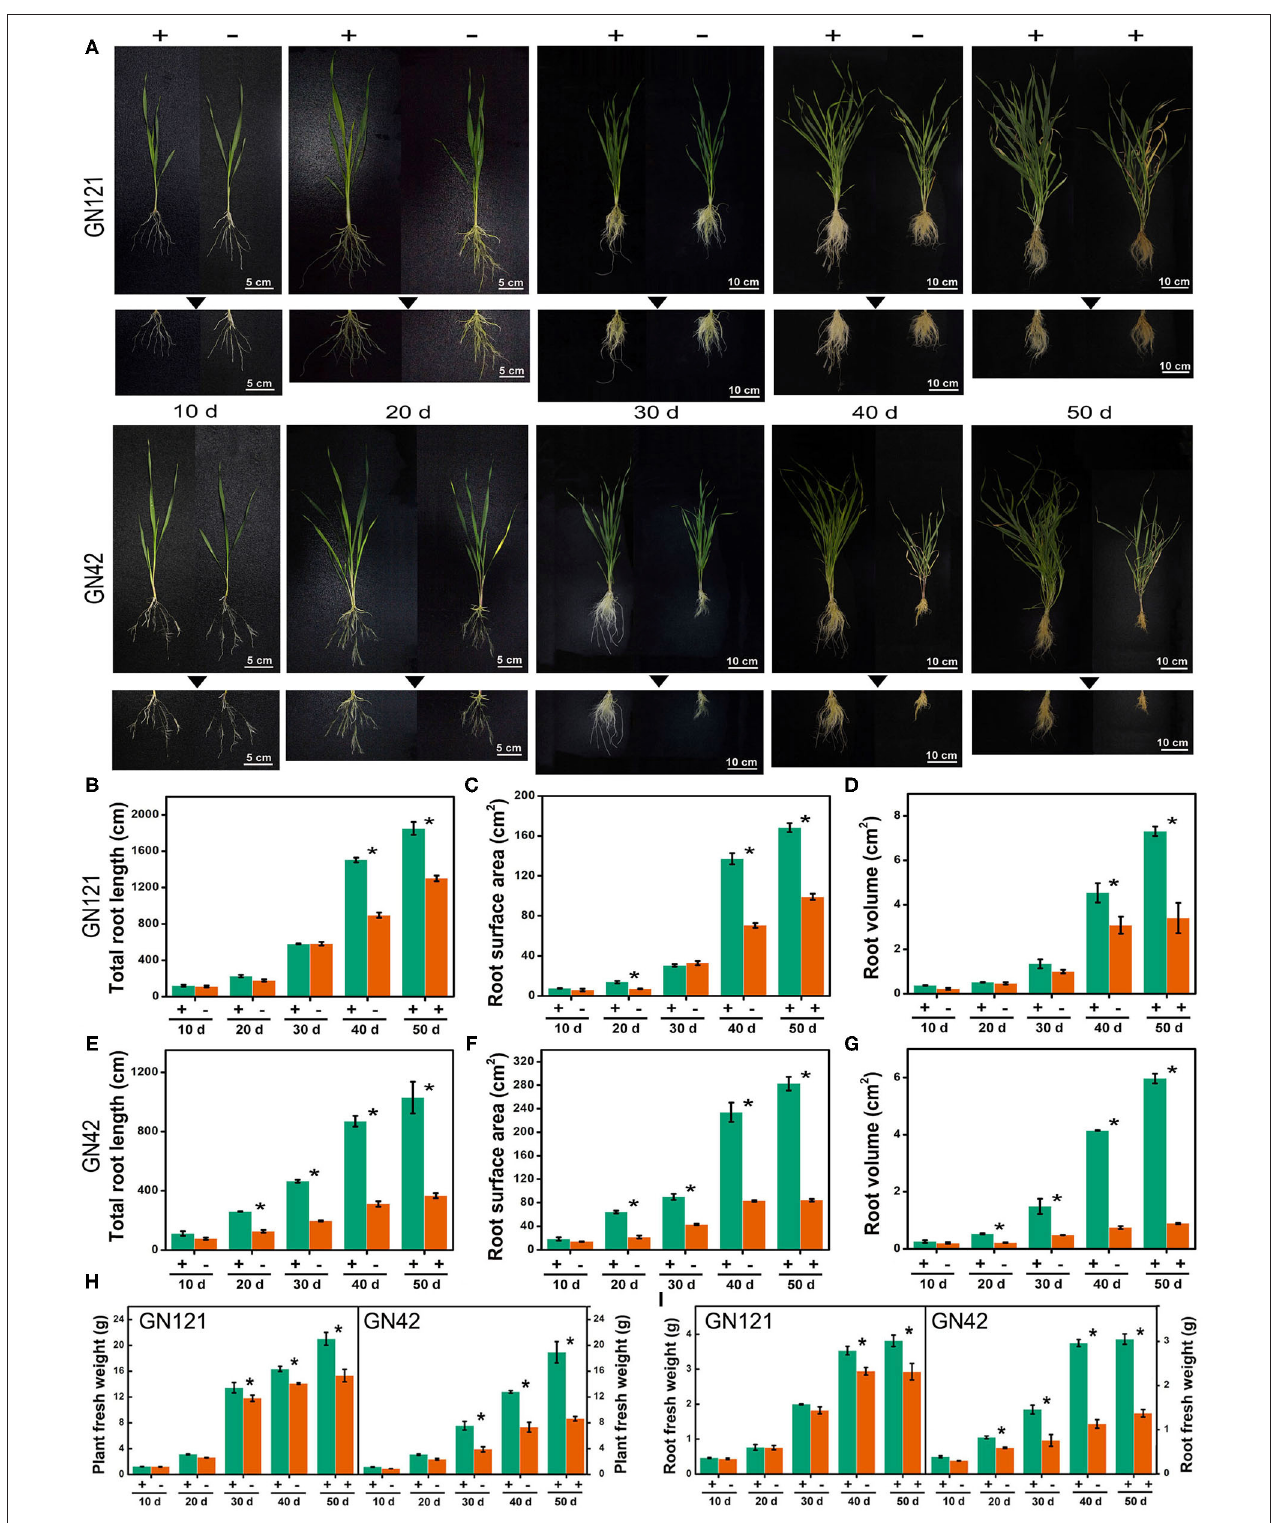
FIGURE 1 | Root characteristics of two barley lines with different low-Pi tolerance in response to Pi starvation and recovery. (A) GN121 (Pi-tolerant) and GN42 (Pi-sensitive) seedlings grown in normal P ( + , 0.39mM Pi) and low P (–, 0.039mM Pi) for 10, 20, 30, or 40 d, followed by recovery P ( + , 0.39mM P) for 10 d; (B) total root length, (C) root surface area, and (D) root volume of GN121 seedlings; (E) total root length, (F) root surface area, and (G) root volume of GN42 seedlings; (H,I) are plant and root fresh weights of GN121 and GN42 seedlings, respectively. Data are means ± SD ( n = 5); * Indicates significant differences (one-way ANOVA, Duncan, P ≤ 0.05) between normal and Pi